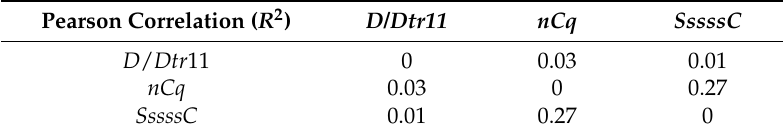
Table 3. Calculated square correlation among the modeled descriptors for Model